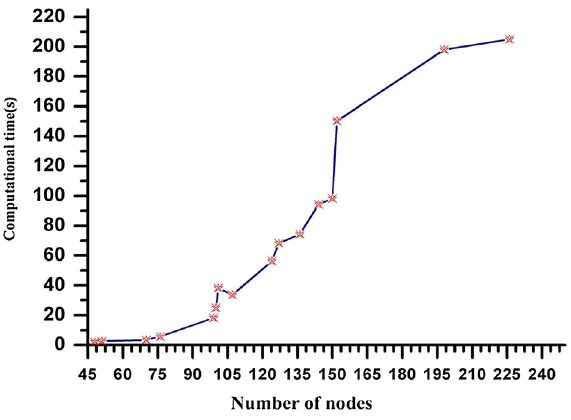
Fig. 8 Problem size versus computational time